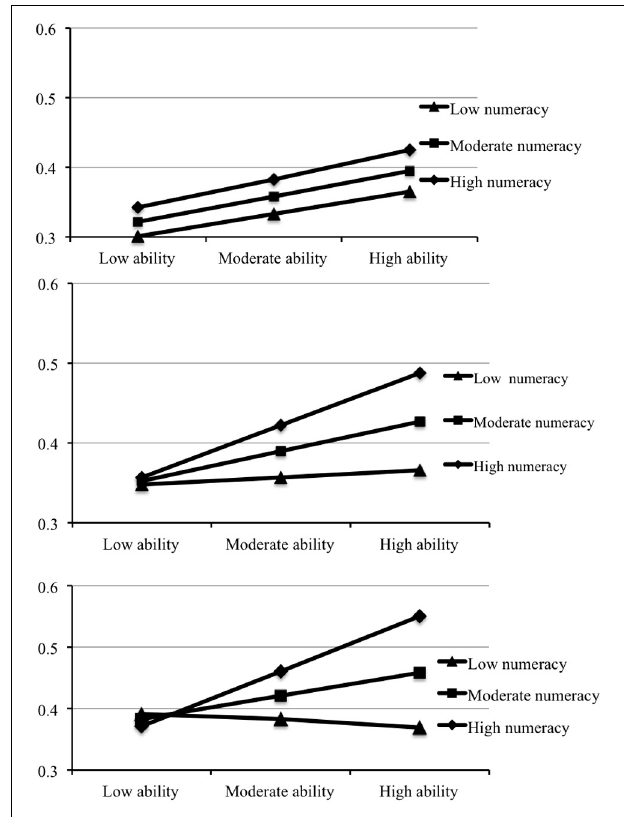
FIGURE 2 | Moderated moderation results: effects of numeracy levels and ability level on normative responding at low (upper graph), moderate (middle graph), and high (bottom graph) TD